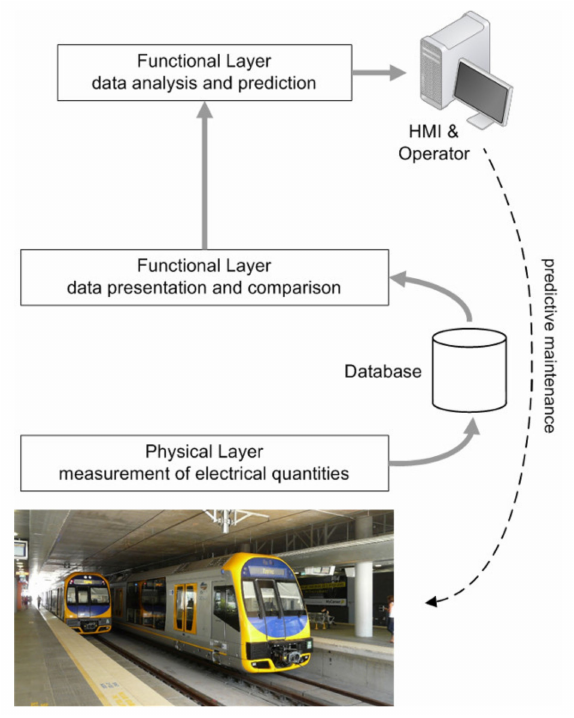
Figure 7. Diagram of the SCMS layers and